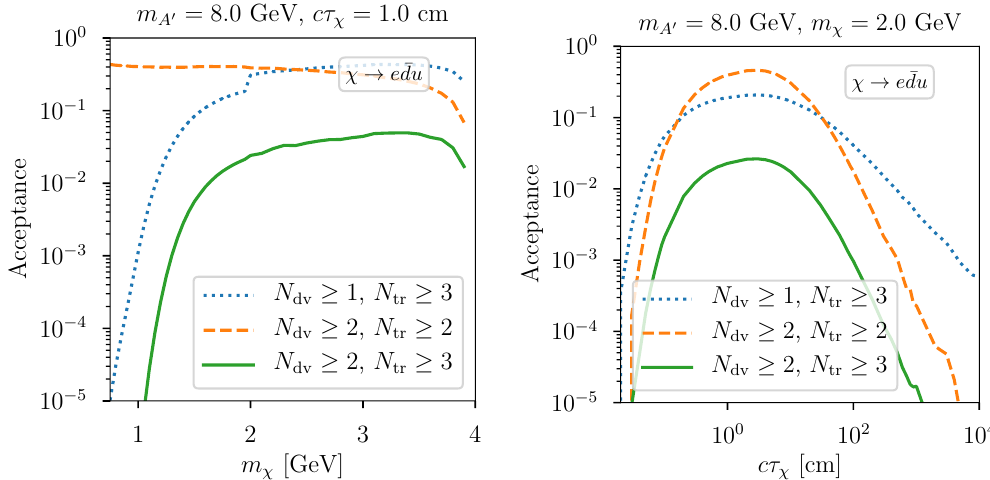
Figure 5 . Slices of the event acceptance probability for fermion LLPs χ decaying to e + hadrons for dark photon production with m a function of the LLP mass for cτ exclusive hadronic decay model of appendix B.1 for m hadronization at larger χ masses; this explains the kink in the left plot at 2 GeV